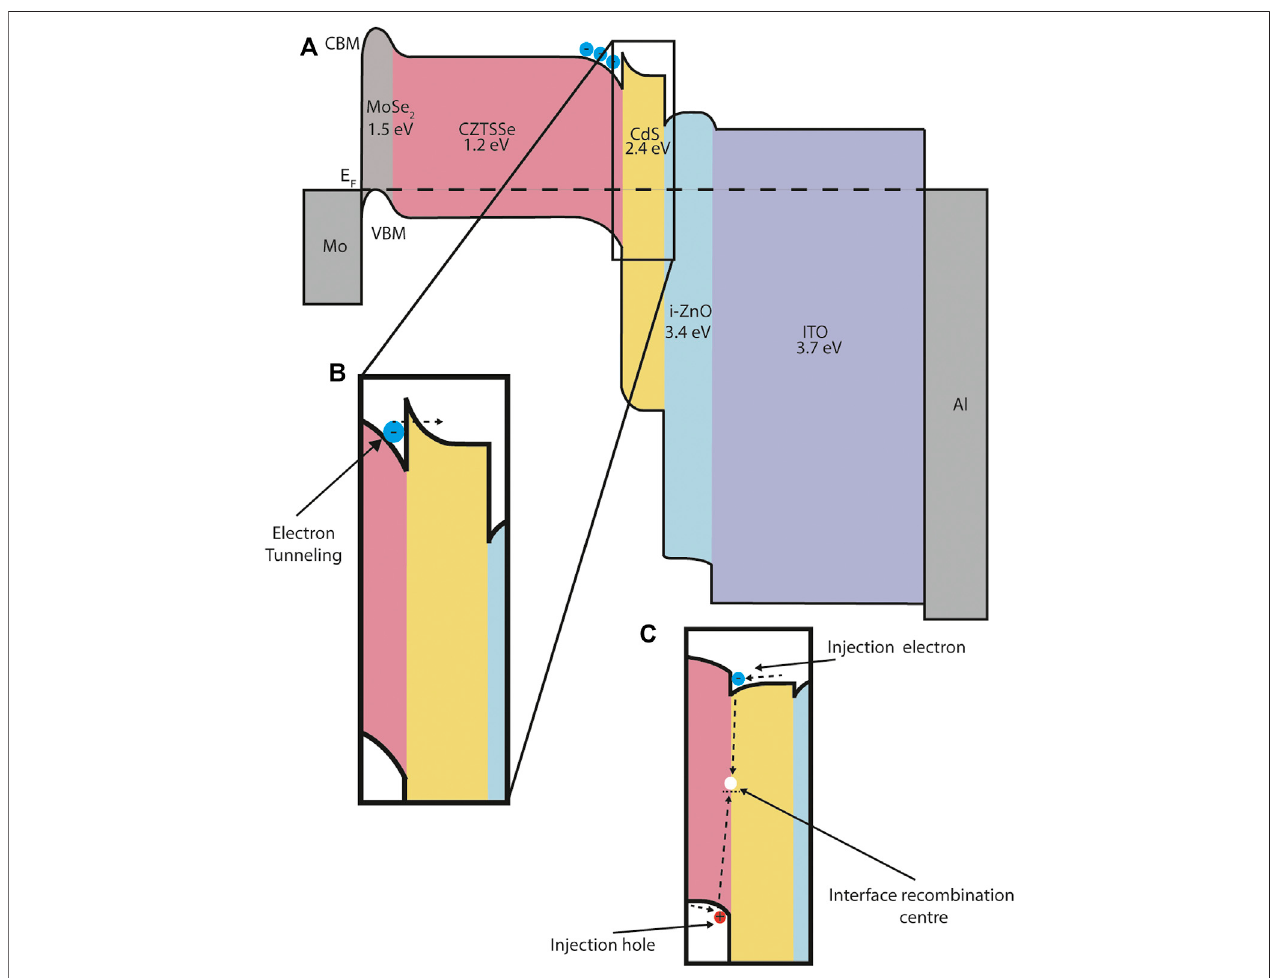
FIGURE6| CZTSSeenergybanddiagramschematic. (A) Themainpanelshowsthebandalignmentacrossthedevice.CBMandVBMrepresentconductionband minimumandvalencebandmaximumrespectively.TheFermi-level E F isdenotedbyadashedline.Thebandgapforeachmaterialisgivenbeloweachchemicalformula. AllmaterialparameterdataistakenfromapreviouslypublishedSCAPSsimulation(Campbelletal.,2020). (B) Photocurrentresistanceatajunctioncanproduceabarrier toelectron fl owandreduceshortcircuitcurrent,dependingontheenergybarrierheight.FortheCZTSSe/CdSinterfaceabarrierlessthan0.4 eVenablestransport through a quantum tunnelling mechanism and is bene fi cial to device performance. (C) Alternative cliff-like band alignment at the CZTSSe/CdS interface. In this case injection electrons or holes (the diffusion current) are impeded by the large offset in available energy states and recombine at the interface. This causes a decrease in the reverse saturation current and a reduction in open-circuit voltage and fi ll